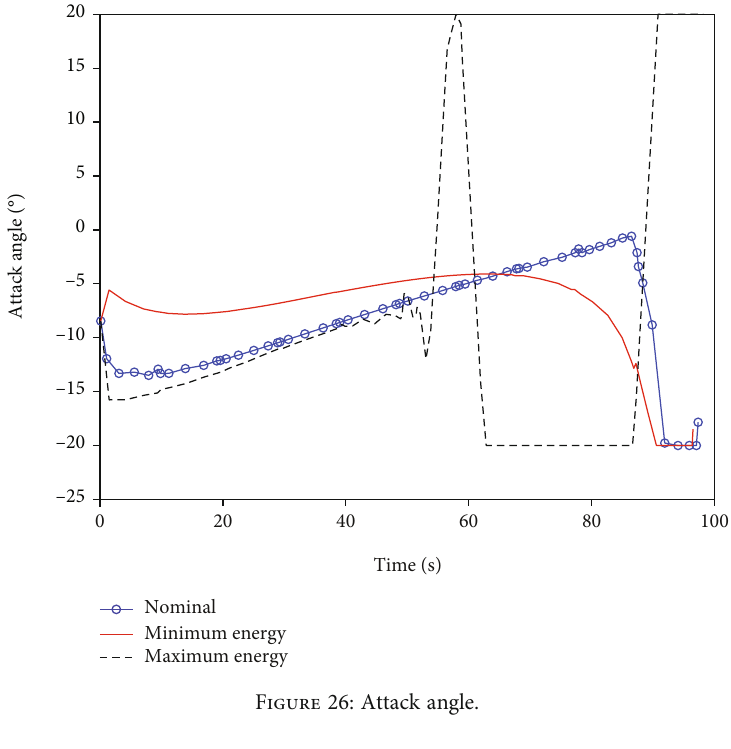
Figure 26: Attack angle.